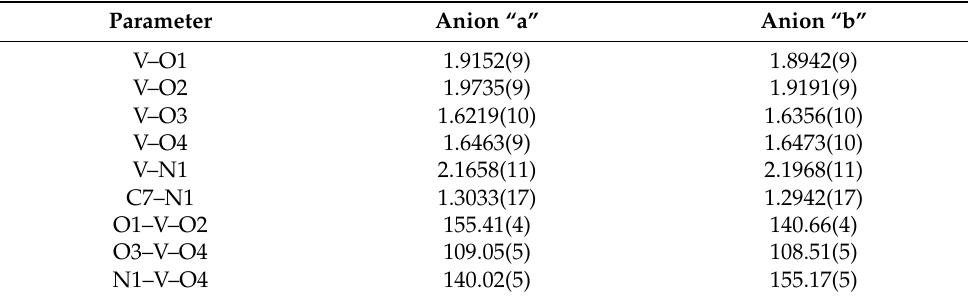
Figure 2. ( a ) Molecular structure of the first independent complex anion of salt 1 showing atom labelling scheme and displacement ellipsoids at the 70% probability level and ( b ) overlay diagram of the independent complex anions of 1 : red image, the molecule shown in ( a ). The molecule anions have been overlapped so the O1, C1, and C2 atoms are coincident. Table 1. Selected geometric parameters (Å, °) for the independent anions in salt 1 .